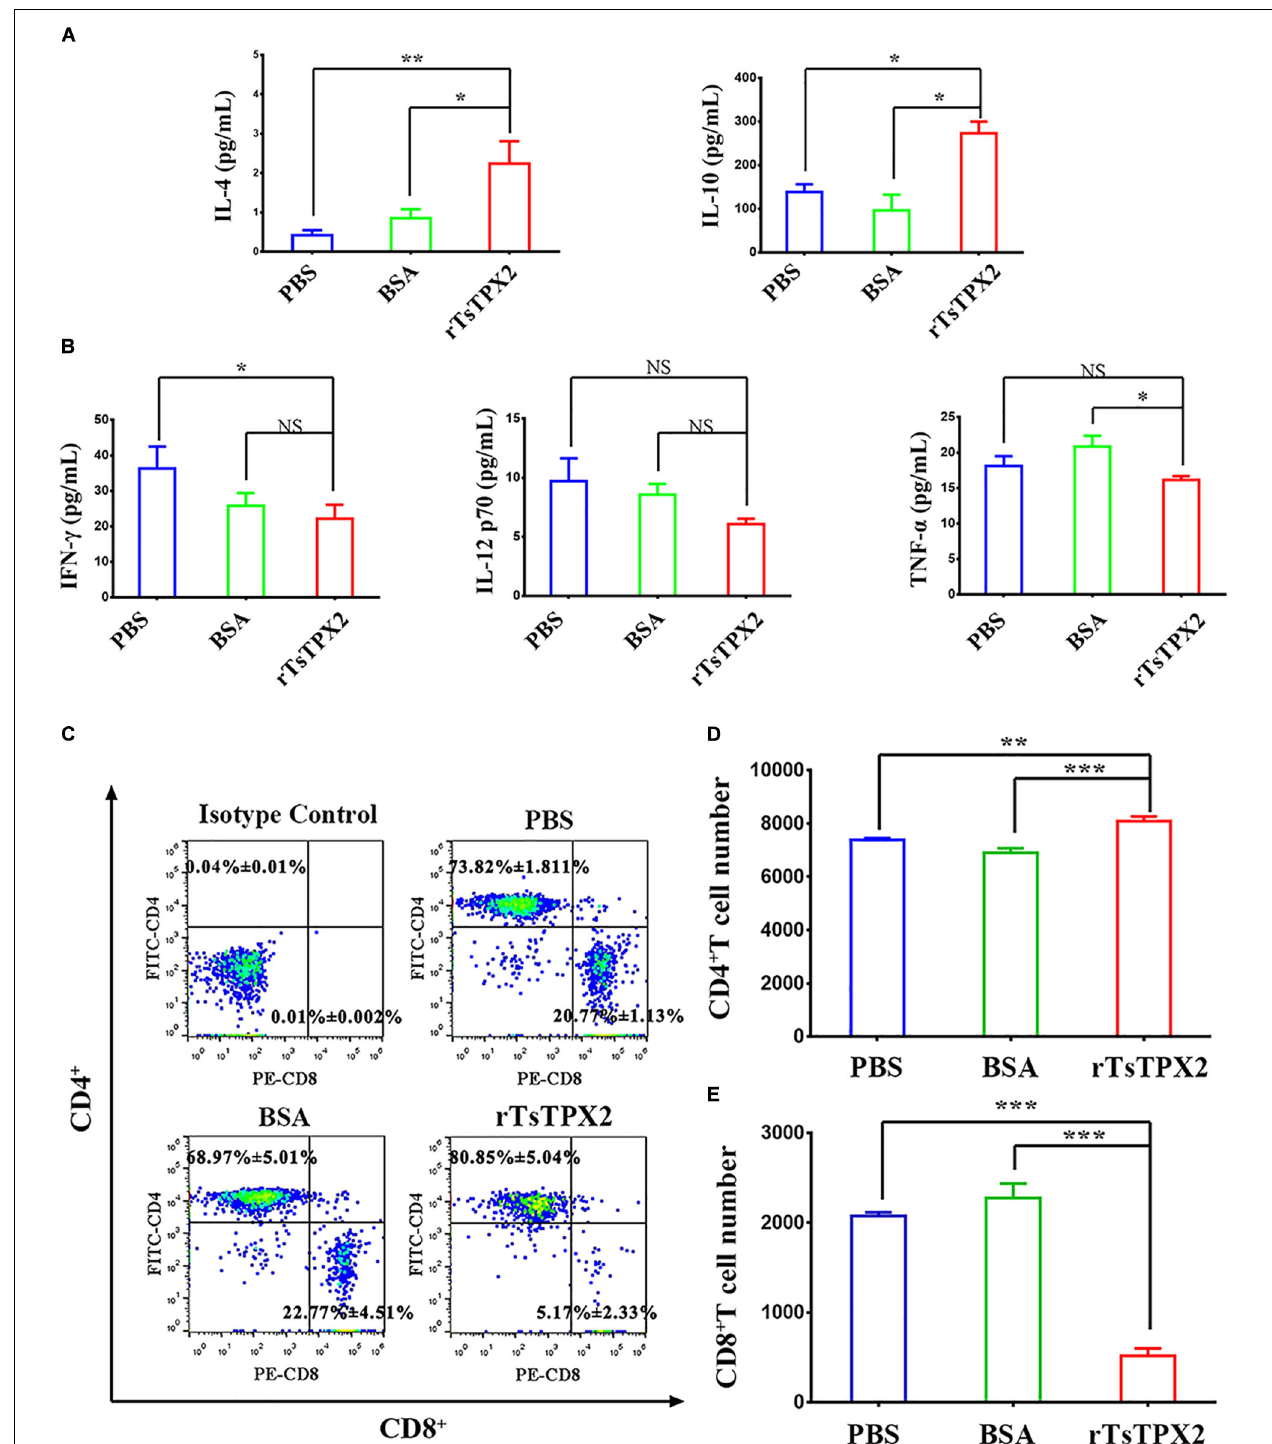
FIGURE 2 | rTsTPX2 inhibits Th1 responses in mice. (A) The levels of Th2 cytokines in sera from mice detected by ELISA. (B) The levels of Th1 cytokines in sera from mice detected by ELISA. (C) Analysis of CD3 + CD4 + CD8 − and CD3 + CD8 + CD4 − T lymphocytes. The number on the representative contour plots showing the ratio of each subset out of peripheral lymphocytes. (D) The total number of CD3 + CD4 + CD8 − T cells in blood from mice. (E) The total number of CD3 + CD8 + CD4 − T cells in blood from mice. Experimental groups include mice challenged with PBS as a negative control, BSA as mock control, or rTsTPX2. Statistical analysis was performed with Student’s t -test, and data are mean ± SDs (representative of three experiments). *** P < 0.001, **0.001 < P < 0.01, *0.01 < P < 0.05. n > = 5 mice per group.